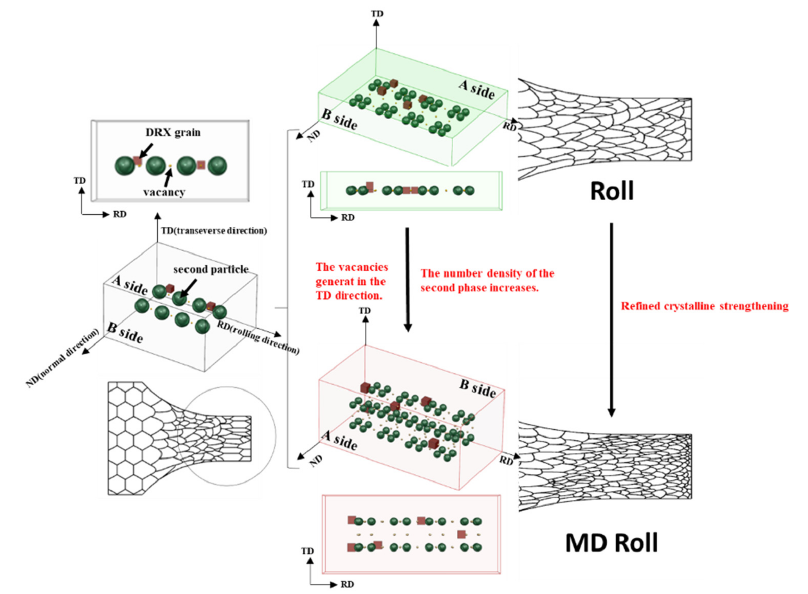
Figure 9. Schematic of distribution of the vacancies and broken second phase